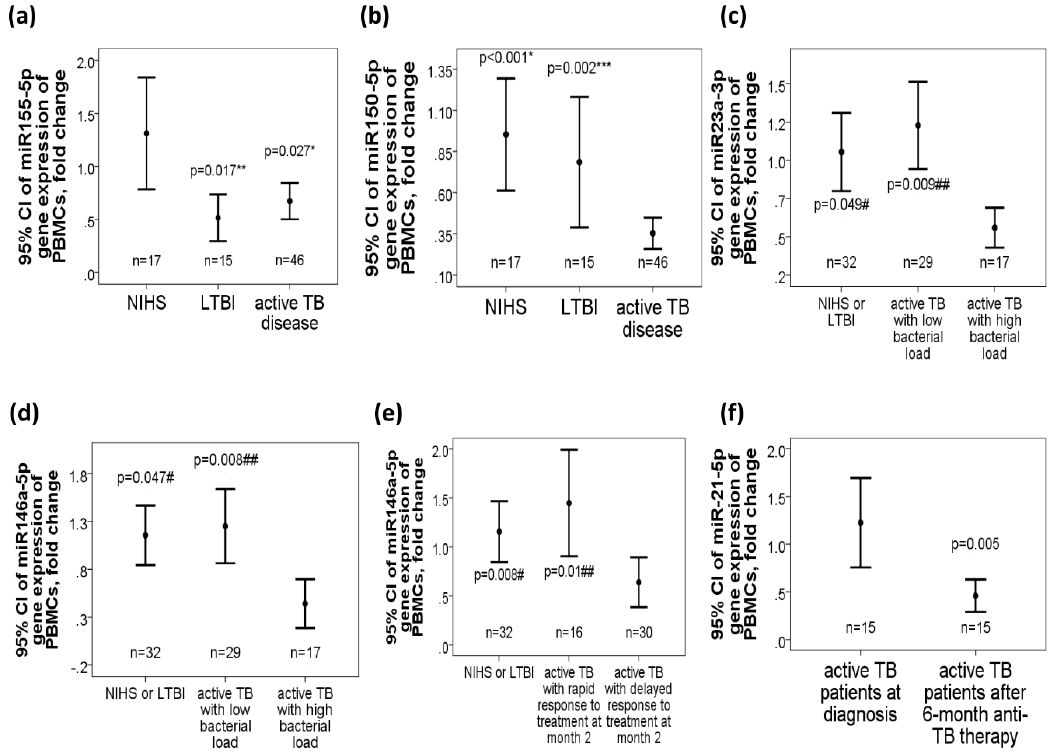
Figure 1. Di ff erential gene expressions of the five microRNAs targeting the toll-like receptor (TLR) pathway in tuberculosis (TB) patients. ( a ) MiR-155-5p gene expression was decreased in patients with active pulmonary TB disease and latent TB infection (LTBI) versus non-infected healthy subjects (NIHS). ( b ) MiR-150-5p gene expression was decreased in the active TB group versus either the LTBI or NIHS group. Gene expressions of both ( c ) miR-23a-3p and ( d ) miR-146a-5p were decreased in active TB patients with high bacterial load versus either those with low bacterial load or NIHS. ( e ) Mir-146a-5p gene expression was further decreased in active TB patients with delayed response to 2-month anti-TB therapy versus either those with rapid response or control group (LTBI + NIHS). ( f ) MiR-21-5p gene expression was reduced in active TB patients after 6-month anti-TB therapy versus before therapy. * p < 0.05, compared between active TB patients and NIHS (adjusted by linear regression analysis model) ** p < 0.05, compared between LTBI and NIHS (adjusted by linear regression analysis model) *** p < 0.05, compared between active TB patients and LTBI (adjusted by linear regression analysis model) # p < 0.05, compared between NIHS and active TB patients with delayed response (adjusted by linear regression analysis model) ## p < 0.05, compared between active TB patients with delayed response and those with rapid response (adjusted by linear regression analysis model).